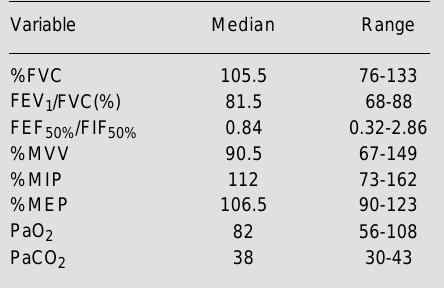
Table 2 - Pulmonary function test and arterial blood gases in OSA